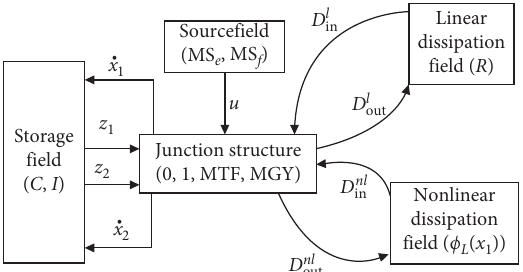
Figure 2: Bond graph of a class of nonlinear systems with integral